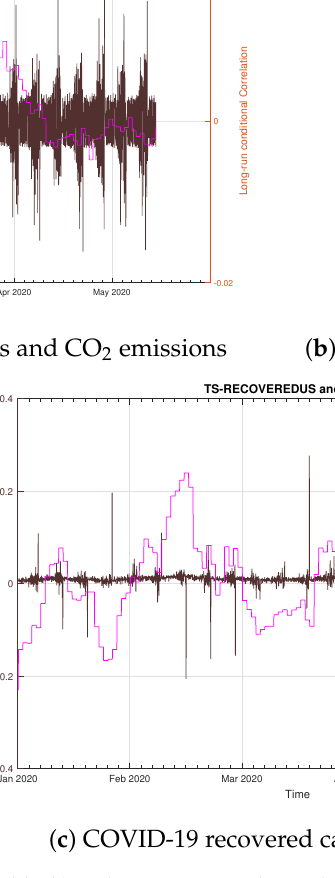
Figure 6. Conditional correlation (black) and Long-run conditional correlation (red) when introducing COVID-19 recovered cases in the baseline